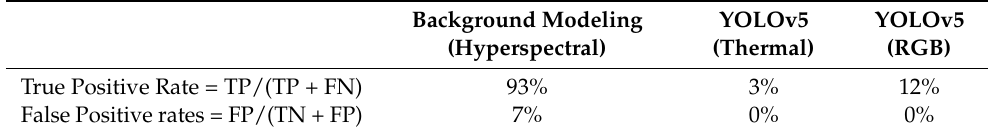
Table 1. Comparison of the background modeling algorithm with dep learning